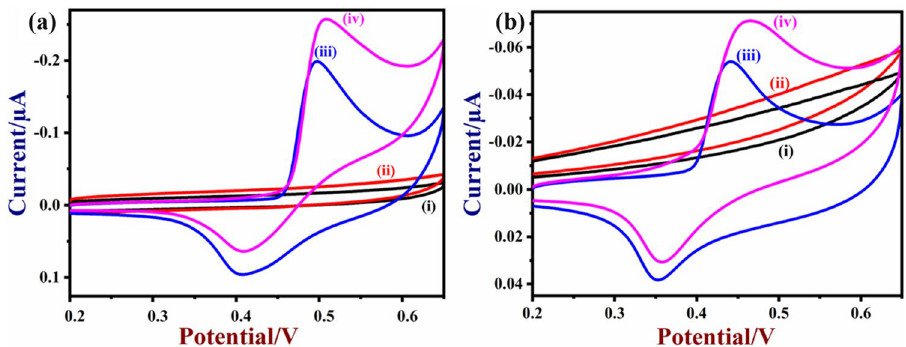
Figure 7. ( a ) CVs of bare-GCE and NiO/MoSe 2 /GCE in 0.1 M NaOH in the absence (curves i and iii) and presence of 50 µM glucose (curves ii and iv). ( b ) CVs of MoSe 2 /GCE and NiO/GCE in 0.1 M NaOH in the absence (curves i and iii) and presence of 50 µM glucose (curves ii and iv). Scan rate = 50 mVs −1 .